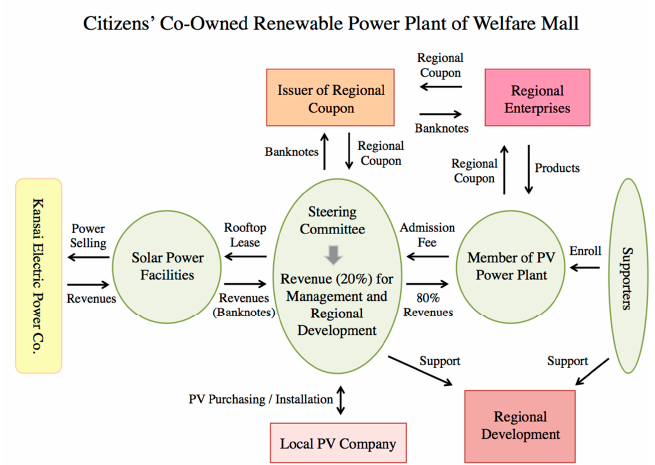
Figure 6. A model that uses regional currencies and allocates profits based on electricity generation. Source modified from Nomura (2013); Prefecture-Shiga (2017).